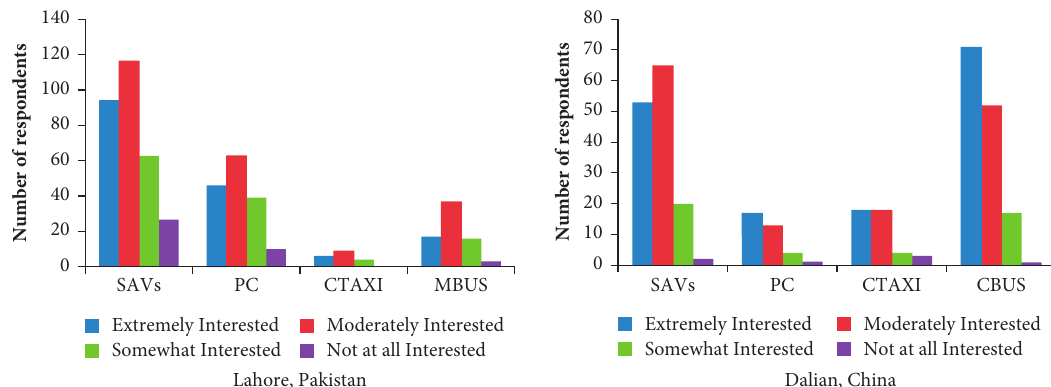
Figure 5: Preferences of automation interested individuals to schooling and working trips